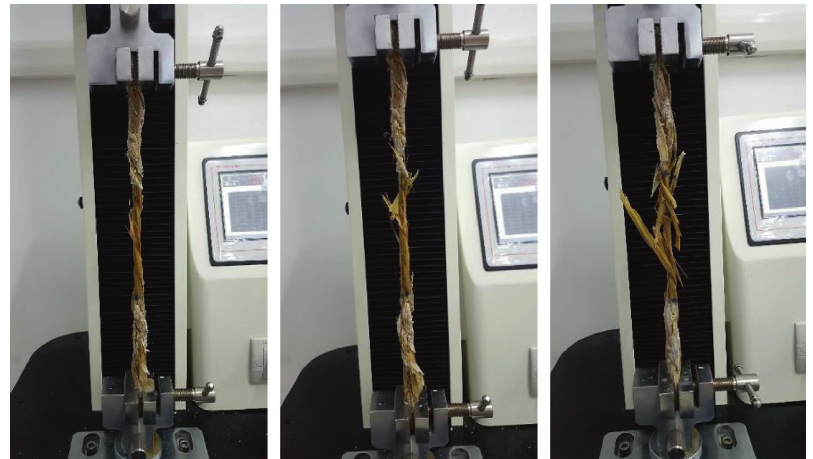
Figure 8: Tensile failure process.